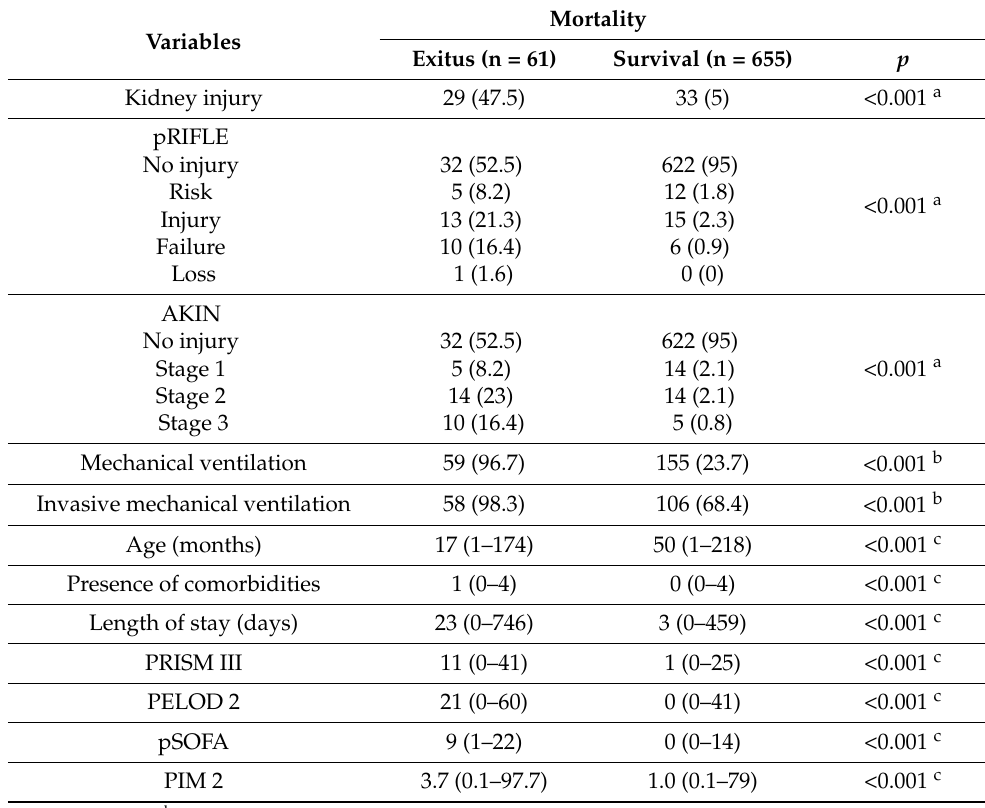
Table 2. Comparison of the presence of acute kidney injury according to the pRIFLE and AKIN criteria and the presence of mechanical ventilation in critically ill children regarding prognosis.